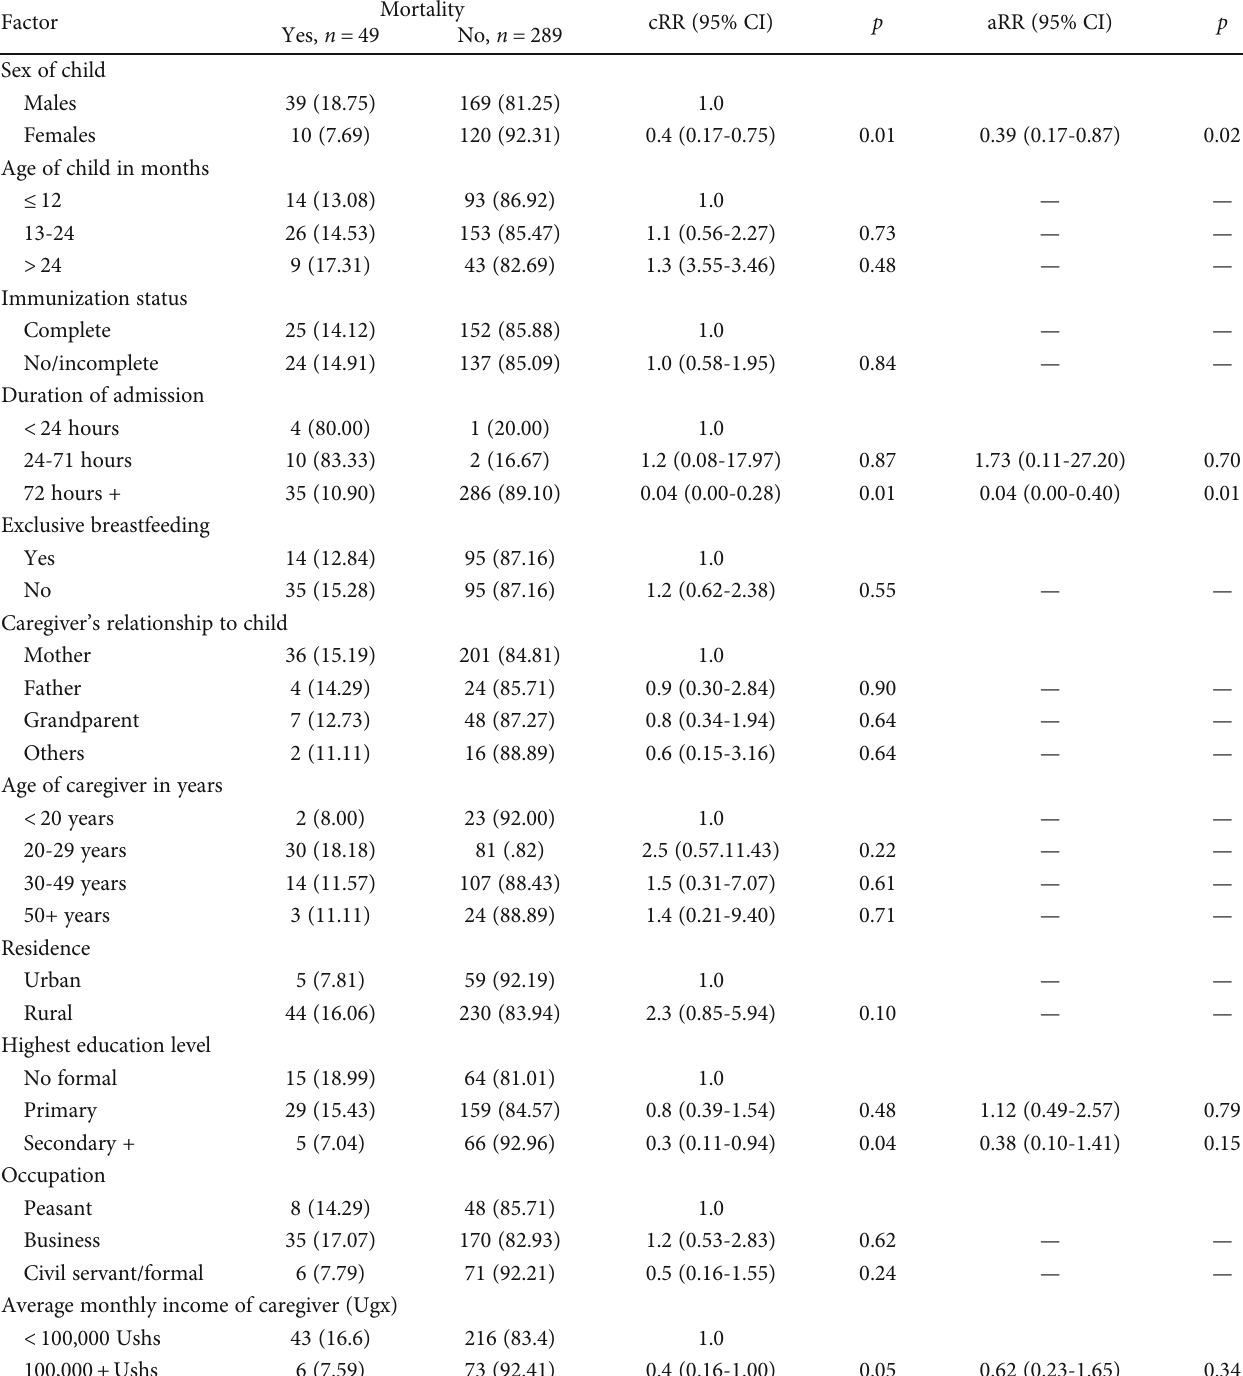
Table 1: Factors associated with mortality among children below 5 years with severe acute malnutrition in